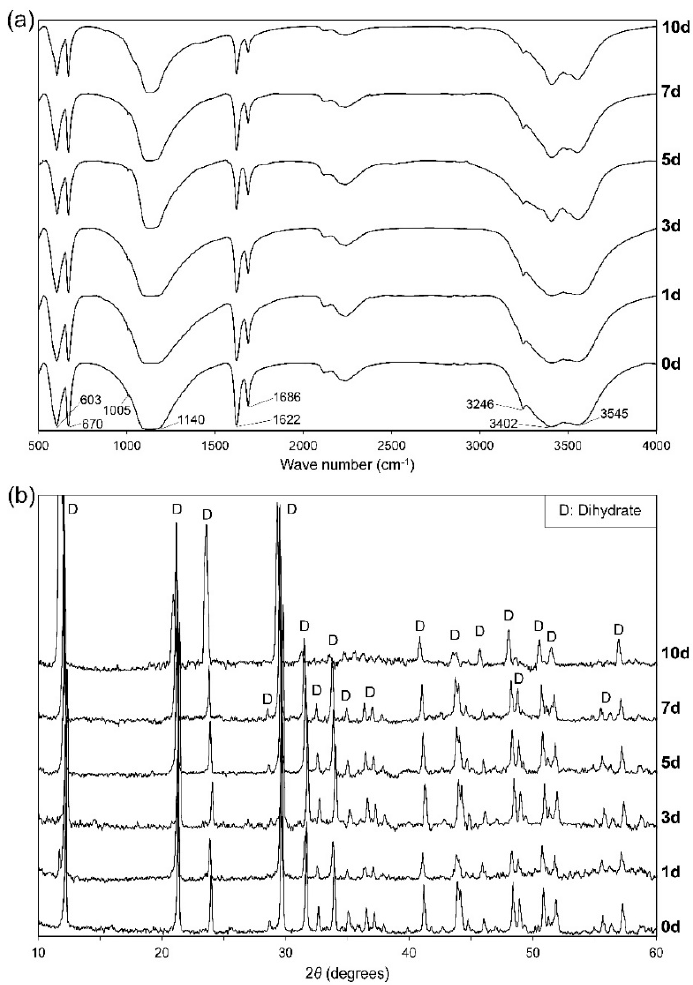
Figure 5. ( a ) FTIR spectra and ( b ) X-ray diffraction patterns of calcium sulfate (CS) cements after 0, 1, 3, 5, 7, and 10 days immersed in Tris–SBF-27